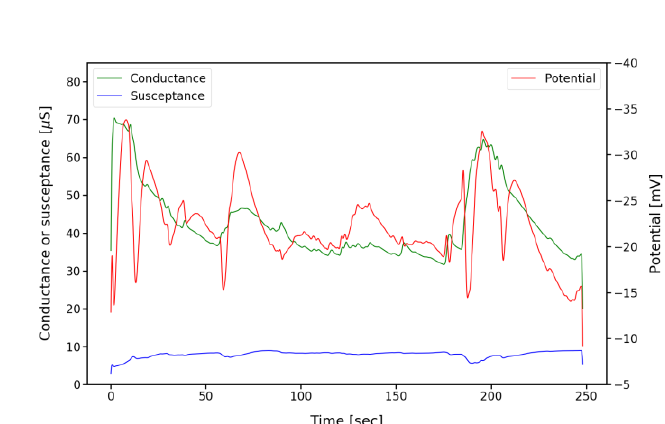
Fig.2: Measurements on a 20-year-old female healthy volunteer. Measured conductance in green, susceptance in blue and potential in red (right hand Y-axis).